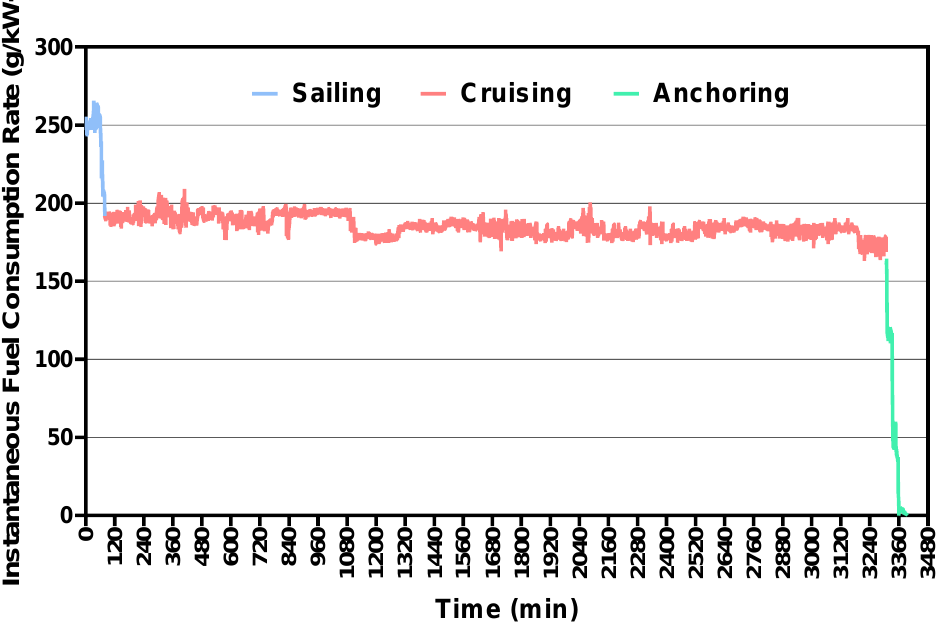
Figure 2. Instantaneous fuel-consumption rate of the ship over the entire voyage. Measured results of pollutant concentration in the ship-exhaust gas. The instantaneous- emission concentrations of the SO 2 , NO x , and CO 2 in the ship exhaust gas for every minute are shown in Figure 3. The variation trends in the concentrations of the SO 2 , NO x , and CO 2 were consistent with each other and rapidly increased in the sailing period from 0 to 77 min, remained steady in the cruising stage from 77 to 3308 min, and decreased in the anchoring stage from 3308 to 3397 min. The ranges of the instantaneous-emission concen- trations of the SO 2 , NO x , and CO 2 were 58.3 ppm~90.1 ppm, 653.21 ppm~974.61 ppm, and 31,000 ppm~43,000 ppm, respectively.